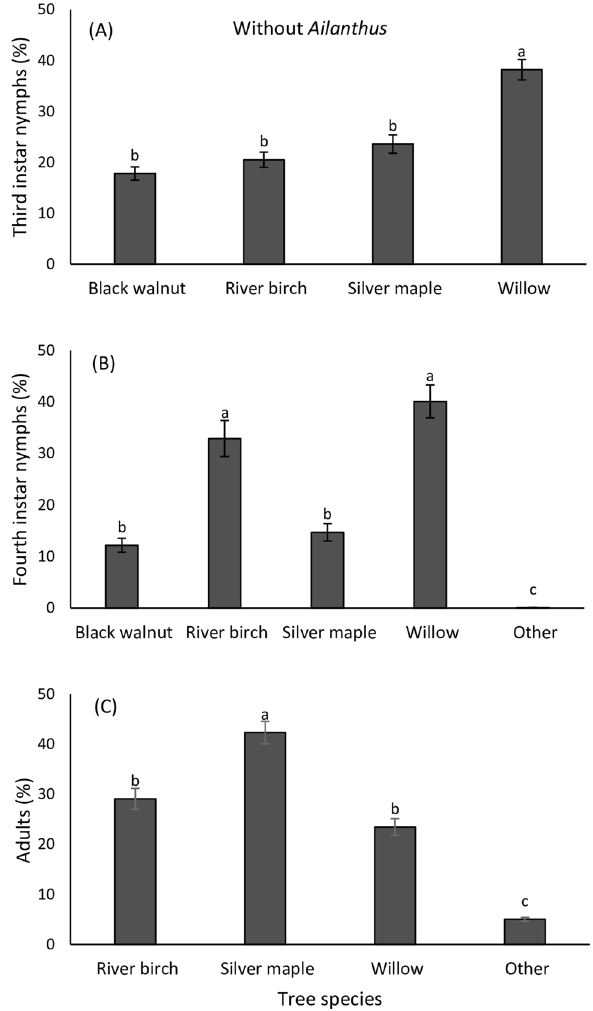
Figure 6. Mean (± SE) proportion of Lycorma delicatula third instars ( A ), fourth instars ( B ) and adults ( C ) present on each tree species in enclosures with silver maple ( Acer saccharinum ), black walnut ( Juglans nigra ) , willow ( Salix babylonica ) and river birch ( Betula nigra ) (without Ailanthus altissima , n = 5 enclosures) from July 15 to November 4, 2020. Nymphs and adults found on other plants (2%) within the enclosure or on enclosure walls (98%) are included as ‘Others.’ Means within a column followed by different letters are significantly different (Bonferroni post hoc test: P < 0.05). No adults were found on black walnut and no third instar nymphs were found on other